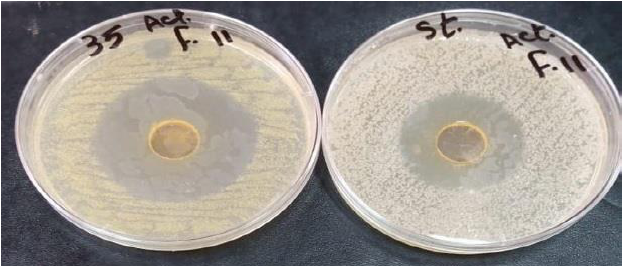
Figure 5. The inhibitive activity of compound 4 isolated from Streptomyces sp. DH7 against multidrug-resistant S. aureus No. 35 and S. aureus ATCC 6538 via the agar well diffusion method. Petri dishes were then incubated for 24 h at 37°C and then the inhibition zone areas were recorded. All tests were performed in duplicates.